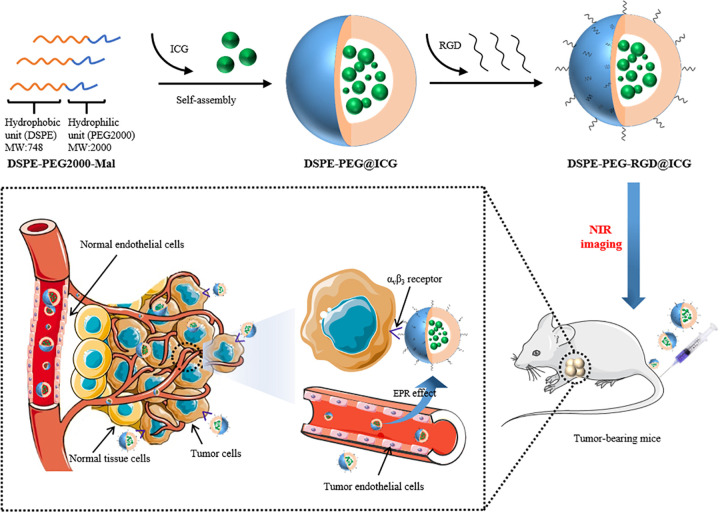
Schematic illustration of RGD targeted DSPE-PEG@ICG micelles for gastric cancer monitor.